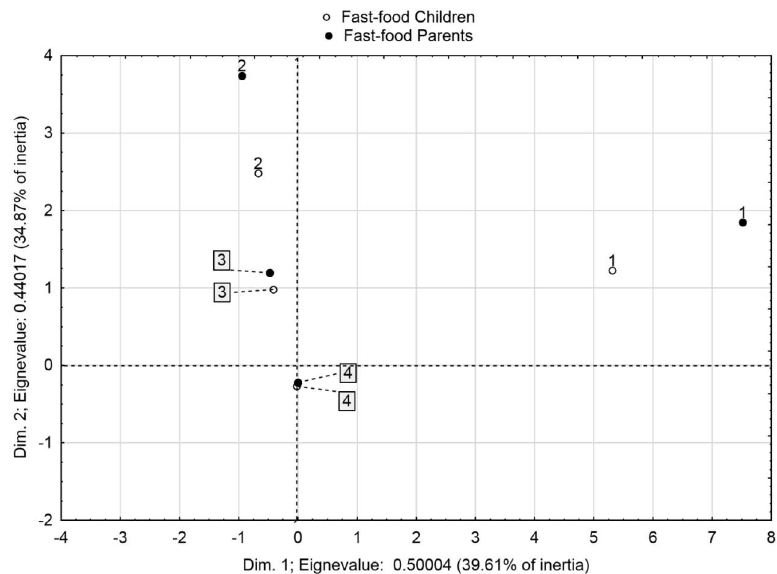
Figure 1. Correspondence map of the frequency of fast-food consumption by parents and children. Categories of frequency of consumption: